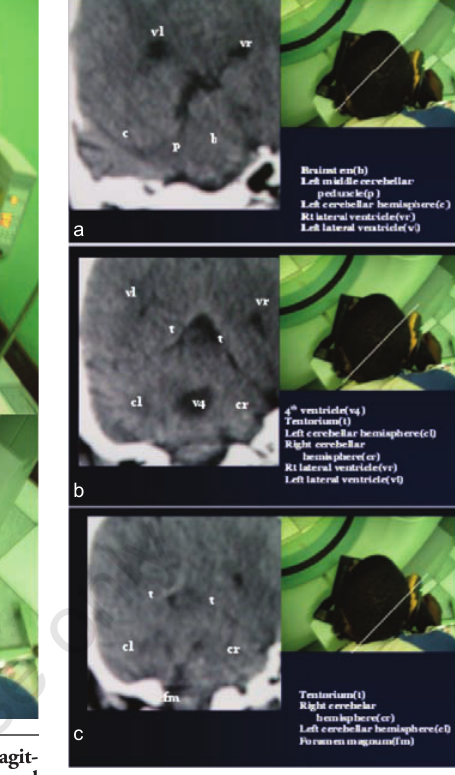
Figure 3. Anatomy of the posterior fossa by 40° sagittal oblique scans. (a) Scan through the brainstem. (b) Scan through the 4 th ven- tricle. (c) Scan through the cerebellar hemispheres behind the 4th